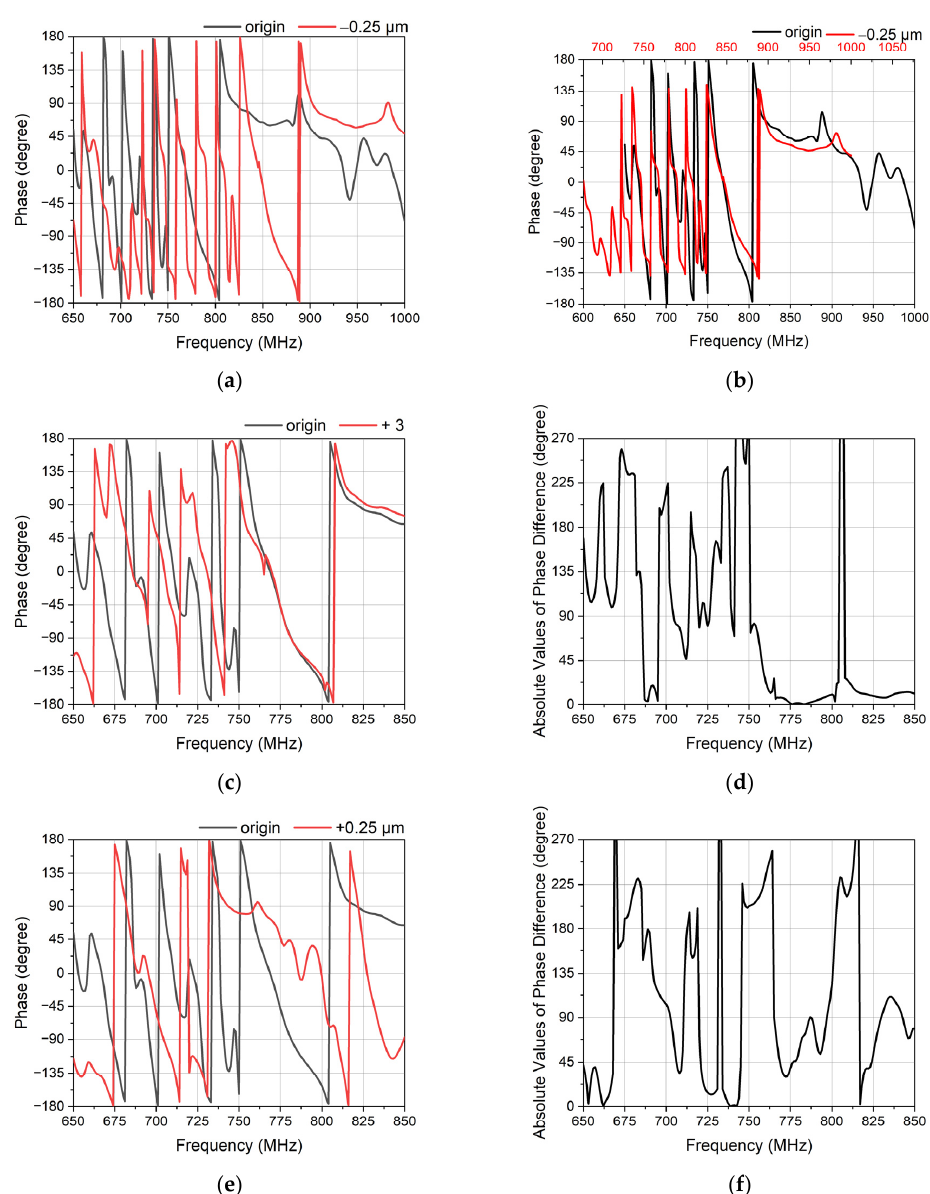
Figure 10. The response of the phase shifter with different parameters. ( a ) The phase of different 𝜆 . The 𝜆 of the red one is 0.25 μ m less than the black one. ( b ) The attenuation of different 𝜆 . ( c ) The phase of different numbers of electrodes. The number of electrodes of the red one is 3 larger than the black one. ( d ) The absolute values of the phase difference of the different number of electrodes. ( e ) The phase of the different widths of the EWC electrodes. The widths of the EWC electrodes of the red one is 0.25 μ m larger than the black one. ( f ) The absolute values of the phase difference of different widths of the EWC electrodes.